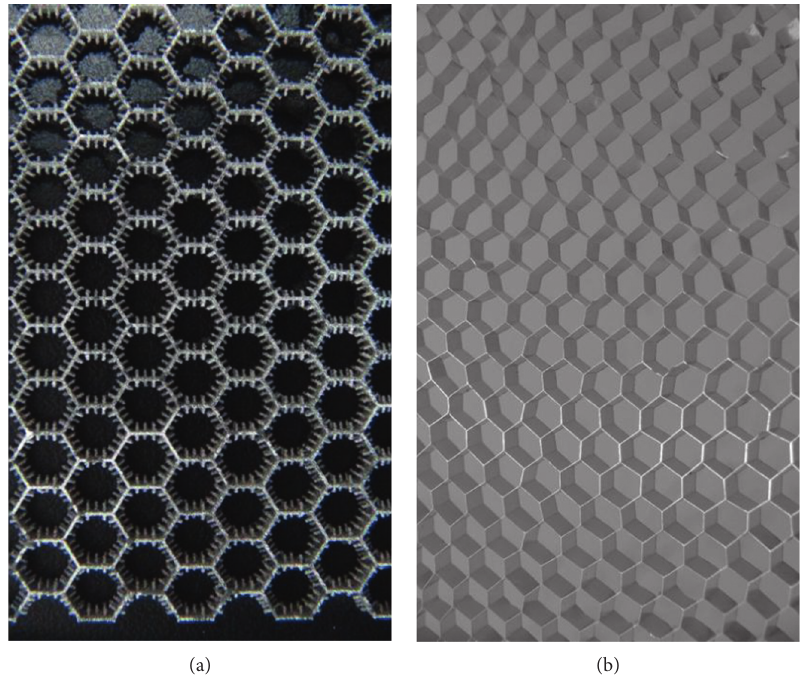
Figure 1: Honeycomb. (a) 3D printing with prickly aluminum honeycomb. (b) Aluminum honeycomb.